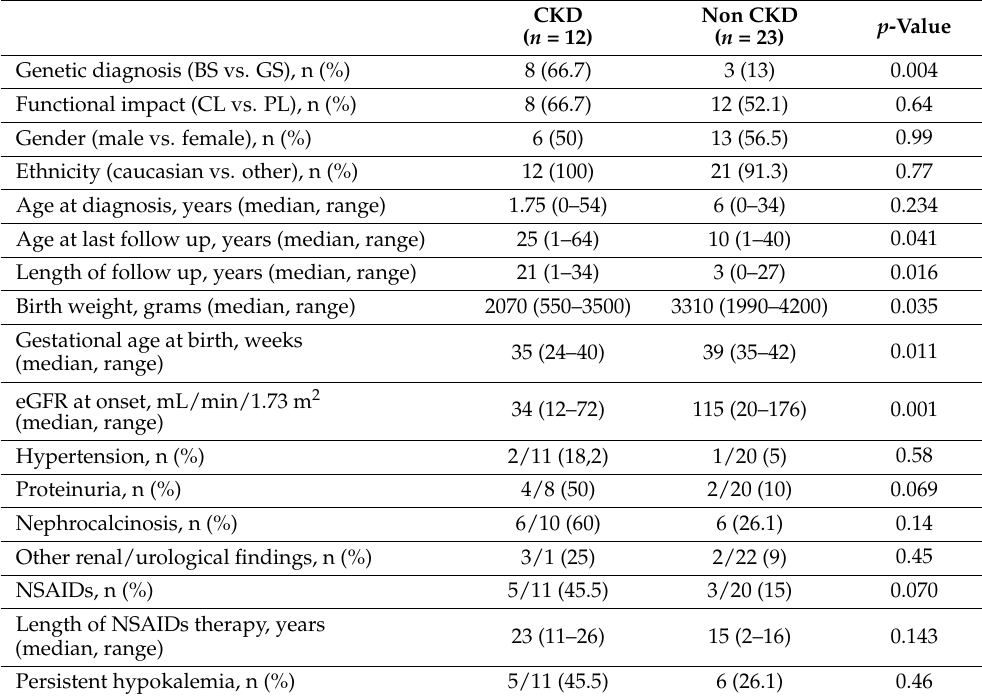
Table 3. Descriptive analysis of clinical and laboratory features of patients with or without CKD and molecular diagnosis of BS or